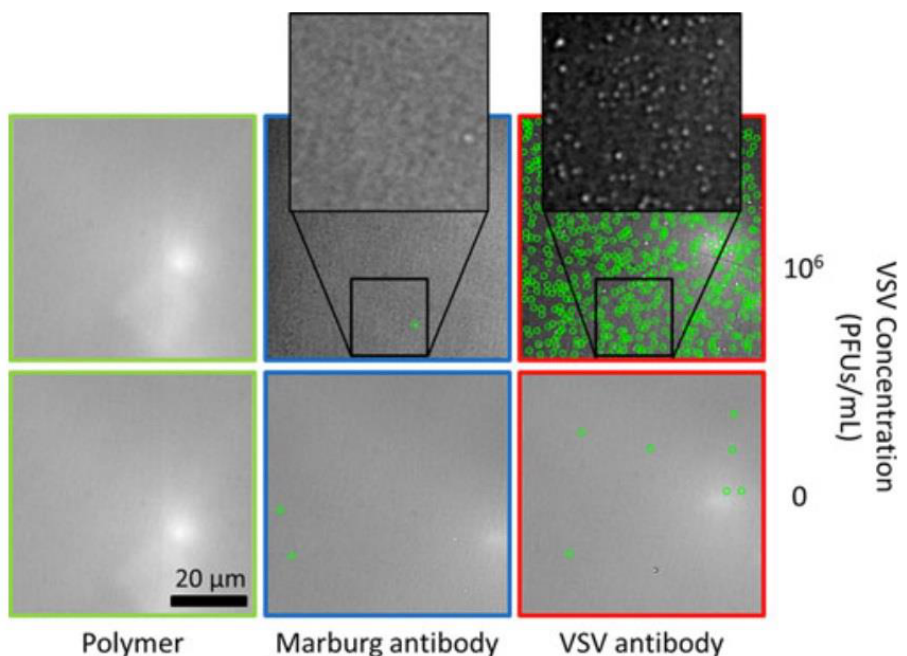
Figure 2. Determining the specificity of the method for VSV. VSV detection (green circles) was seen for concentration 0 and 10 6 PFU/mL [31]. Reproduced with permission from A.P. Reddington, S.